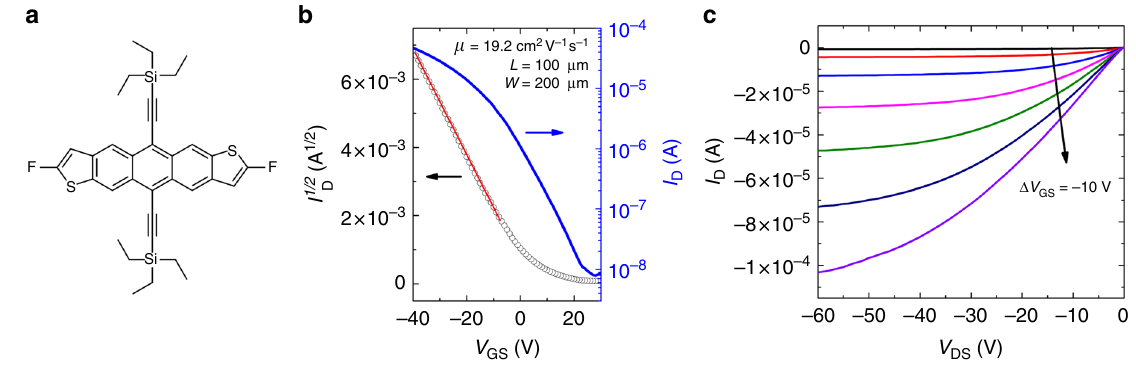
Fig. 1 Electrical properties of OFETs fabricated on diF-TES ADT. a Chemical structure of diF-TES ADT. b Drain current as a function of gate-source voltage in device with channel length L = 100 µ m and channel width W = 200 µ m, in the saturation regime. c Drain current as a function of drain-source voltage for the